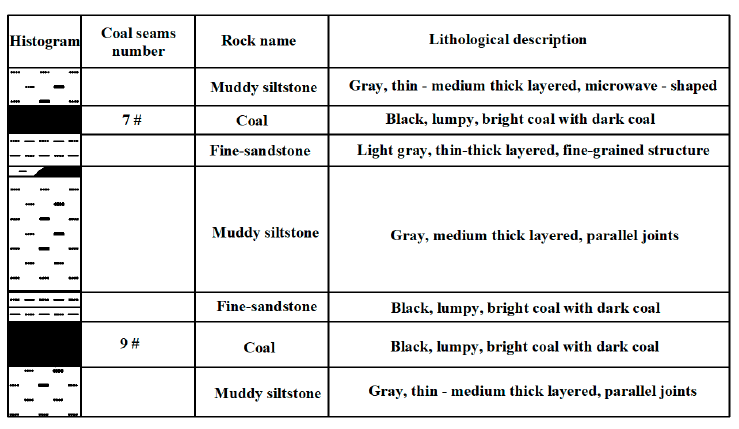
Figure 1. Column diagram of the roof and floor lithology.